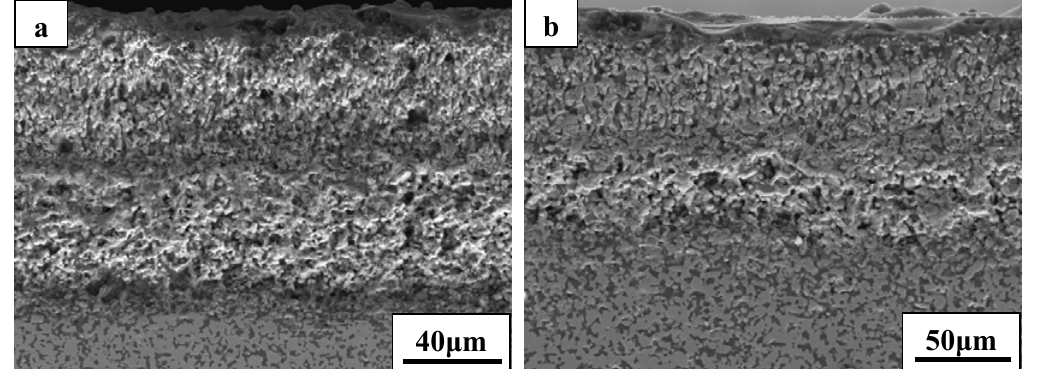
Figure 8. Cross-sectional morphologies of ZS30 after ablation under ( a ) condition 1 and ( b ) condition